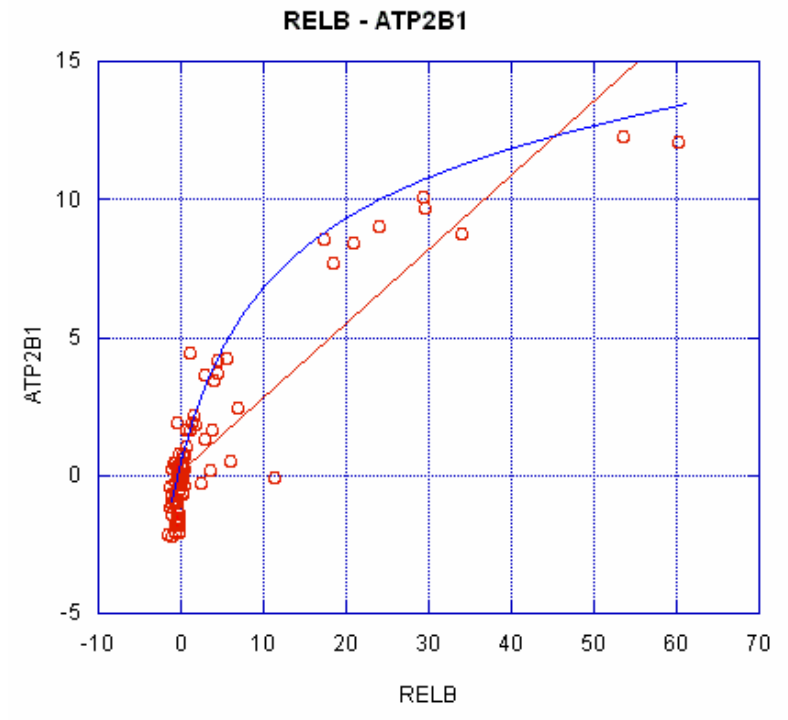
Figure 1: Illustration for TF-gene regulation pattern. Here, the expression data are plotted for TF (RELB) along x-axis, and for gene (ATP2B1) along y-axis. Linear regression (straight line) is unable to capture majority of points, while the non-linear function curve seems to cover most of them.